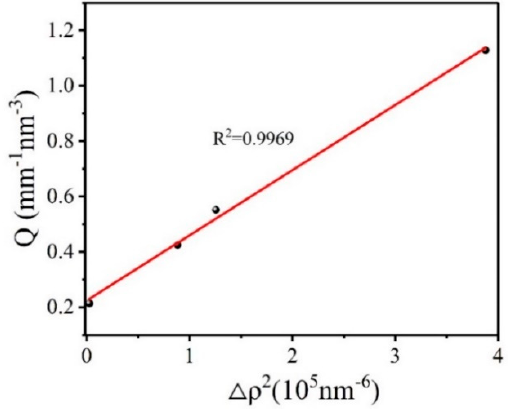
Figure 5. Volume fraction and specific surface of voids in CL-20-1 crystals in different electron density matching solutions.